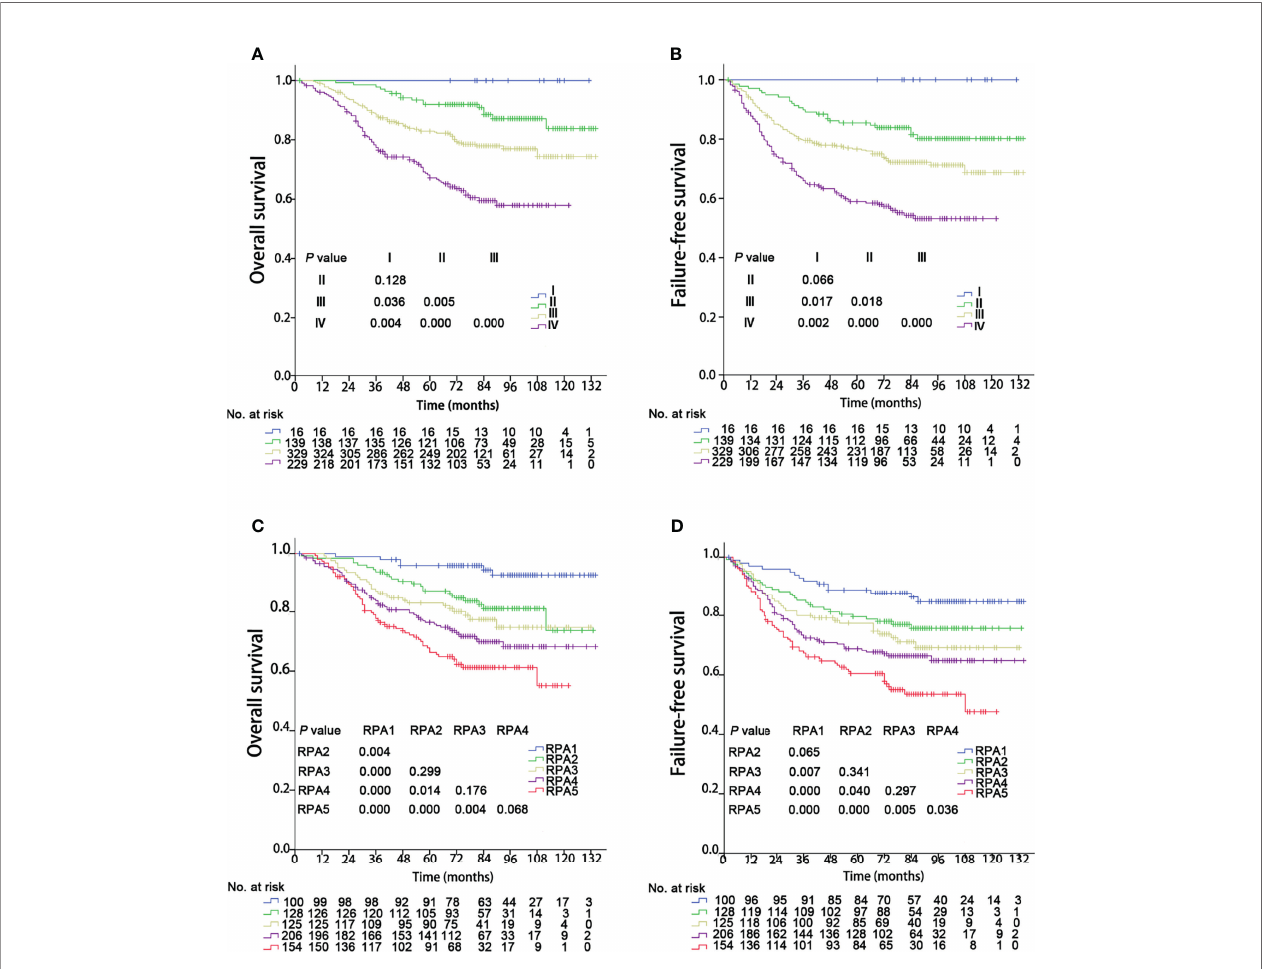
FIGURE 5 | Kaplan – Meier survival curves of 713 patients strati fi ed by the overall stage and RPA groups. RPA, Recursive partitioning analysis. (A, C) Overall survival; (B, D) Failure-free survival.